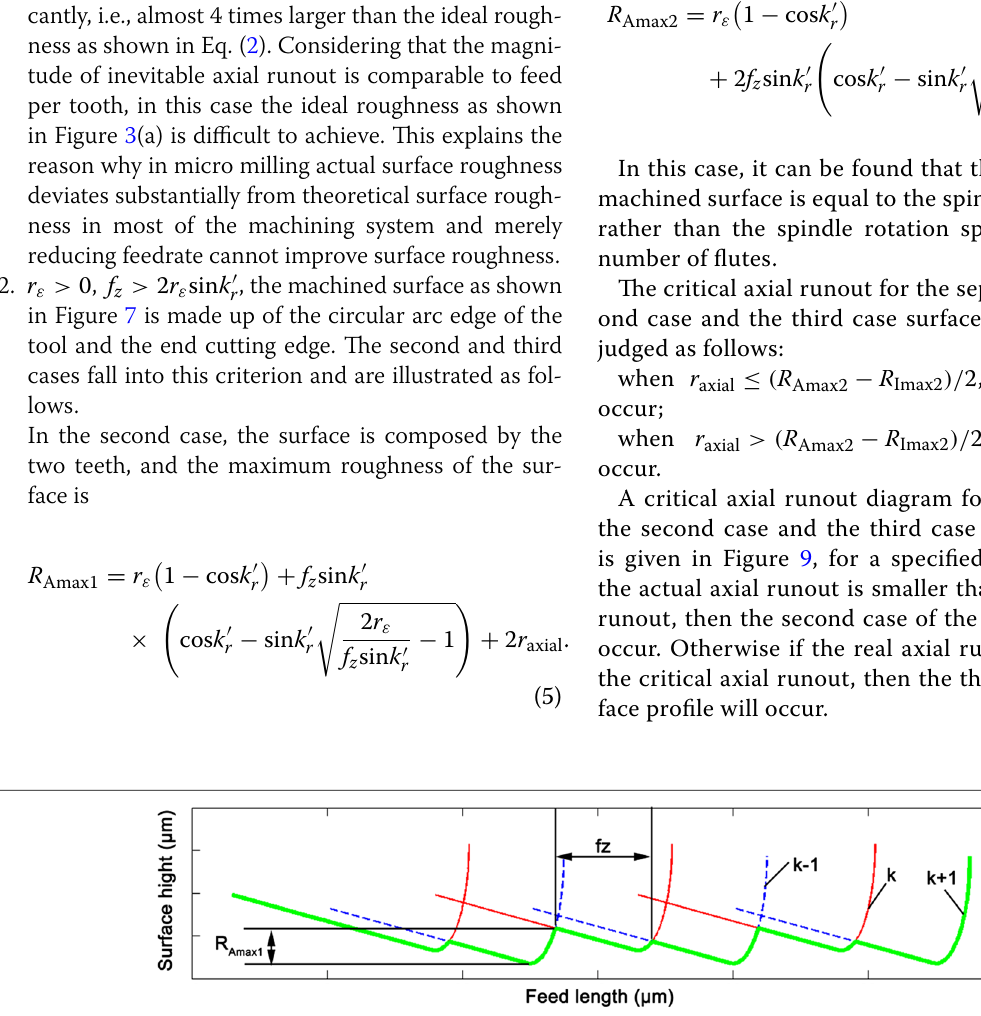
Figure 7 Second case of the surface profile considering radial and axial runout